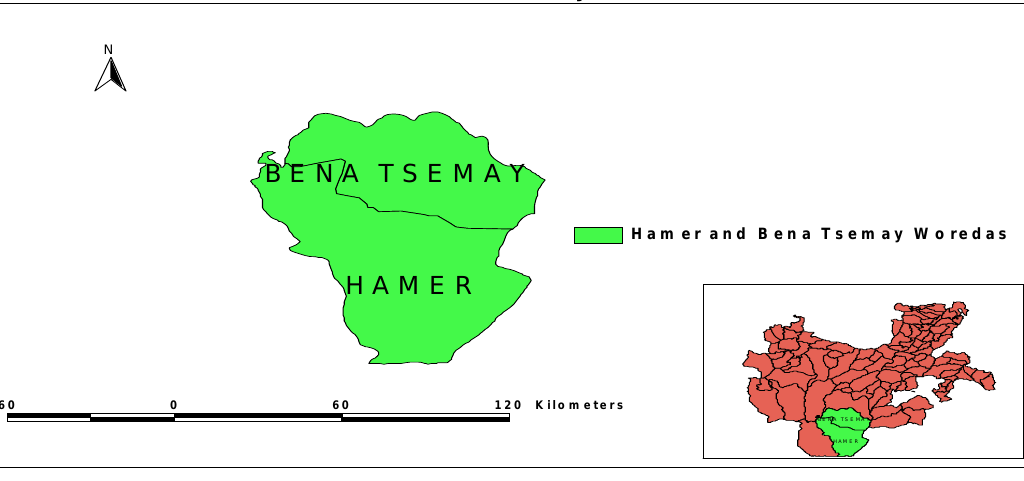
Figure 1. Map of the study